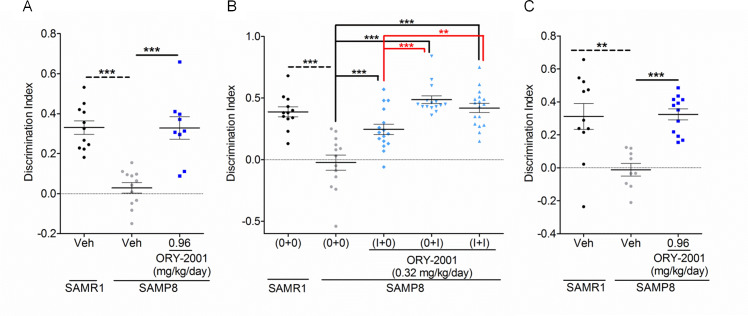
Symptomatic and disease modifying potential of ORY-2001.(A) Effect of one week ORY-2001 treatment on NORT DI (t(19) = 5.230; p < 0.0001; N = 9-12/group), assessed 2 hr after training (B) Effect of ORY-2001 on NORT DI in a crossover design; 0: one month treatment with vehicle; I: one month treatment with ORY-2001 (F3,57 = 25.65; p < 0.0001; N = 12-17/group). (C) Effect of ORY-2001 on DI in the NORT of aged SAMP8 mice (t(19) = 6.600; p < 0.0001; N = 9-12/group). Means and SEM are represented. SAMR1 and SAMP8 vehicle groups were compared by Student t-test. Within SAMP8 mice, different drug treatments were compared by t-test or by oneway-ANOVA with Dunnett and SNK post-hoc analysis. *p < 0.05, **p < 0.01, ***p < 0.001.